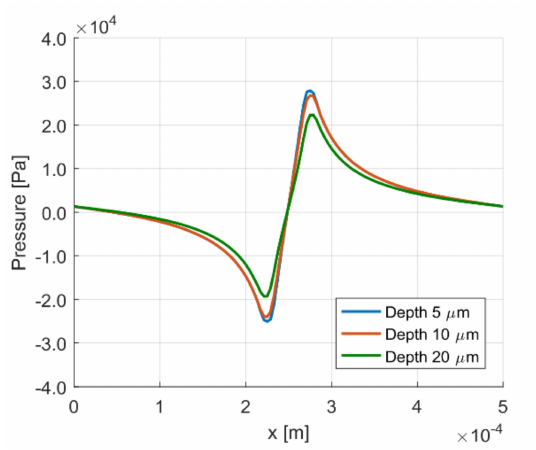
Figure 9. Pressure profiles of a square dimple with side 50 µ m and gap 10 µ m, sliding velocity 5 m / s. Influence of the dimple depth on the pressure distribution.